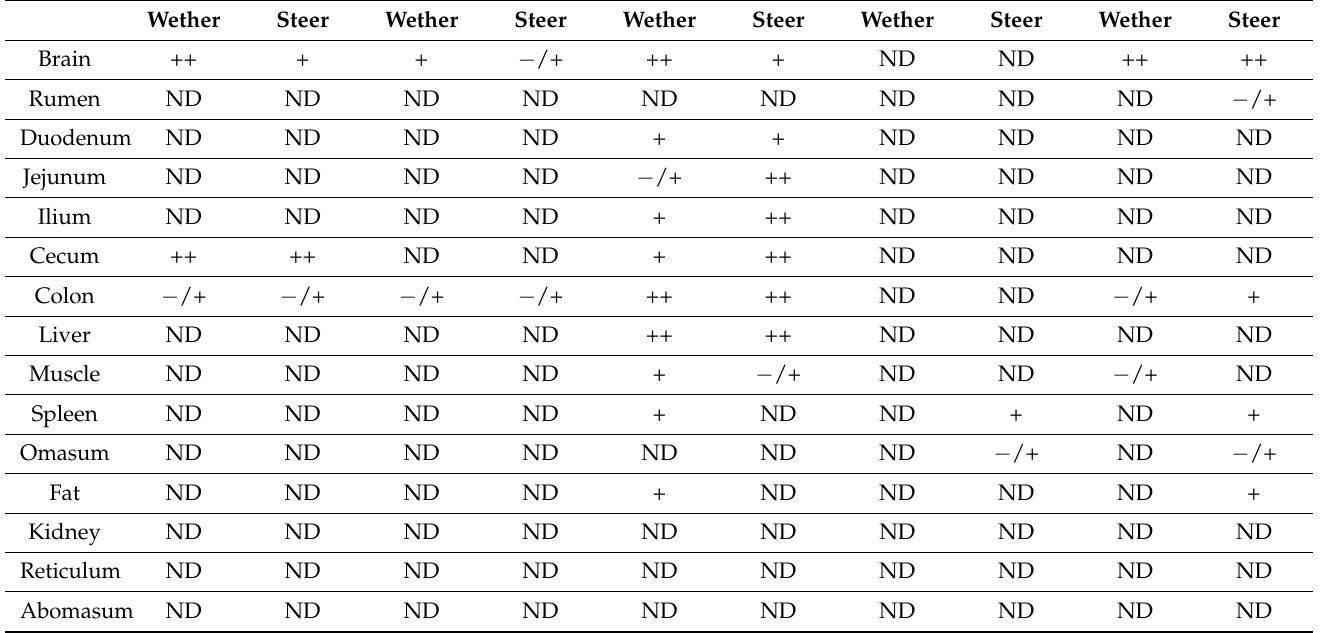
Table 2. Relative mRNA Expression Ranking in Ruminant Tissues. Relative expression rank: High—++, Intermediate—+, Low— − /+, and not detected—ND.